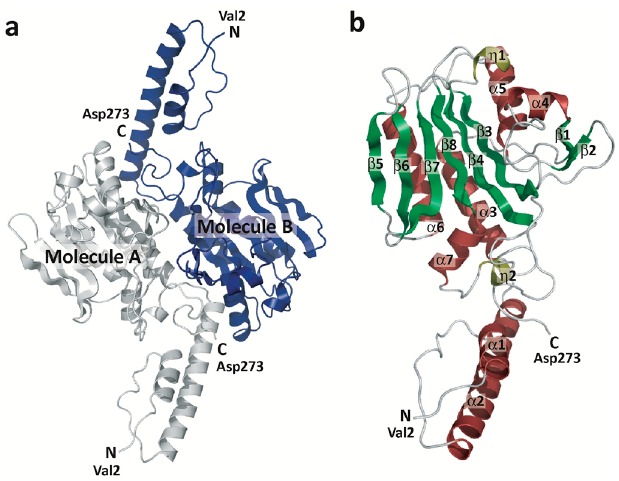
Figure 1. Overview of the ISO4-G1 PylRS structure. ( a ) The ISO4-G1 PylRS dimer. The protomers of the dimer are colored gray-white and blue. The crystallographic 2-fold axis is perpendicular to the paper. ( b ) The α -helices, 3 10 helices, and β -sheets are colored wine red, olive, and green, respectively.